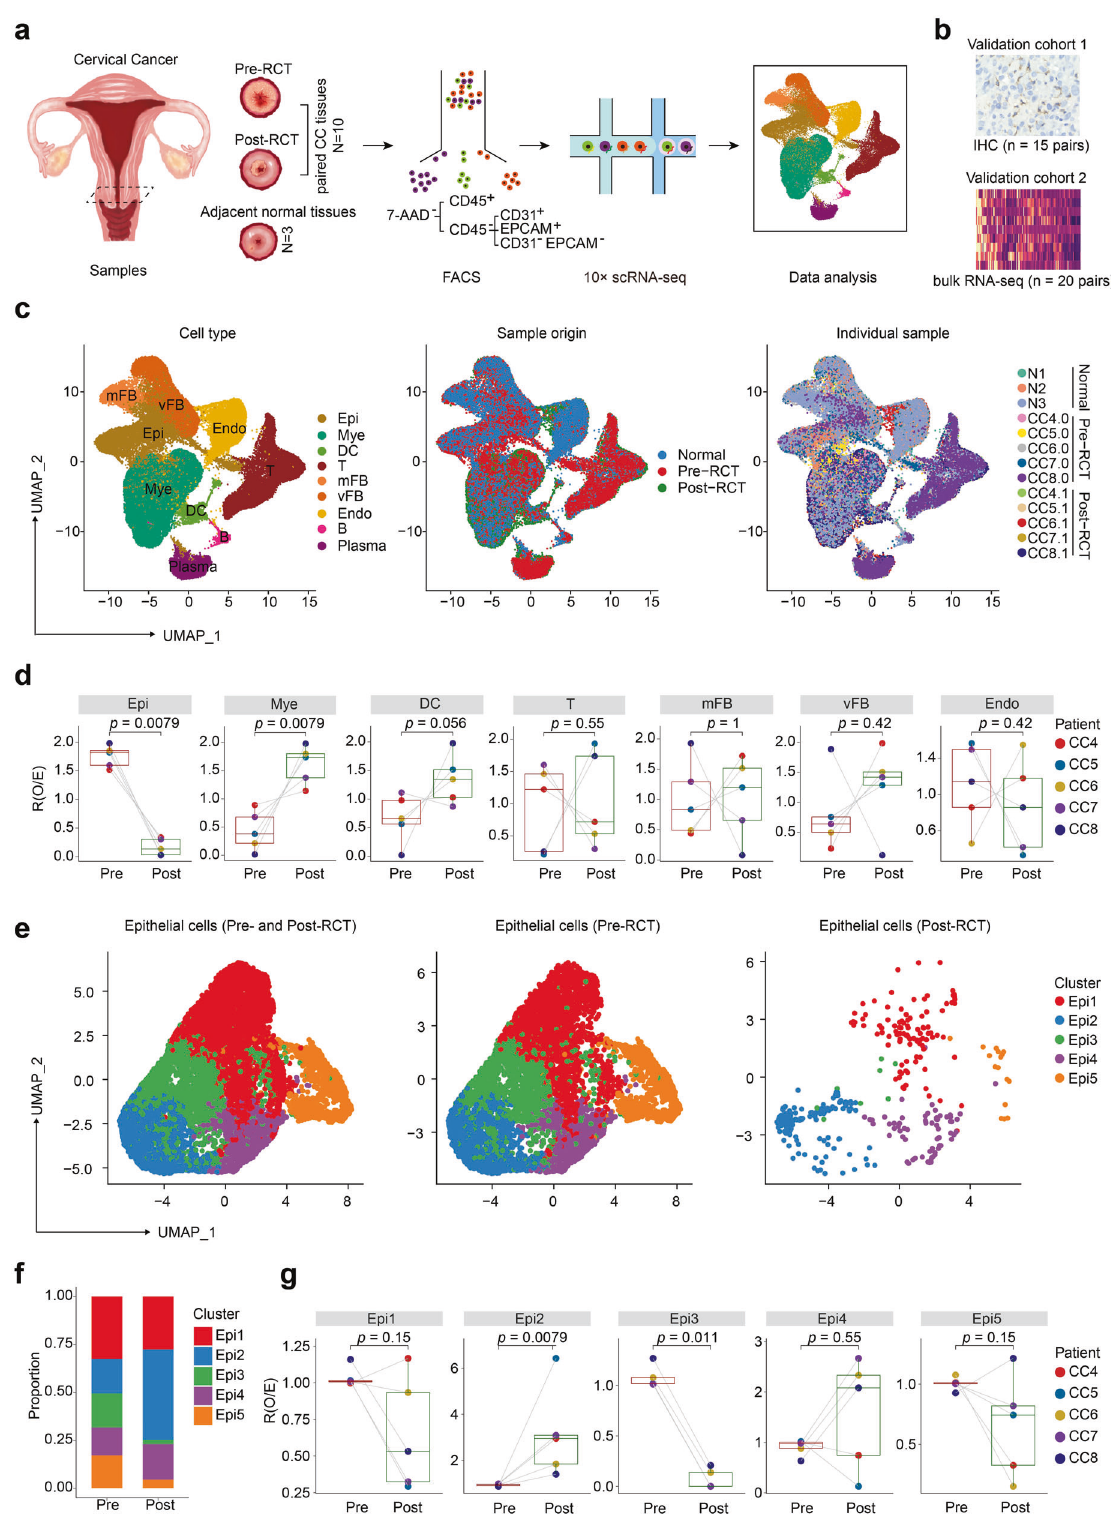
immunohistochemistry (IHC), and validation cohort 2, comprising 20 pairs of bulk RNA-seq data of pre-RCT and post-RCT CC samples (Fig. 1b). For scRNA-seq, we enriched the samples for immune (CD45 + ), epithelial (CD45 − EPCAM + ), endothelial (CD45 − CD31 + ), and fi broblastic cells (CD45 − EpCAM − CD31 − ), and subjected them to Signal Transduction and Targeted Therapy (2023)